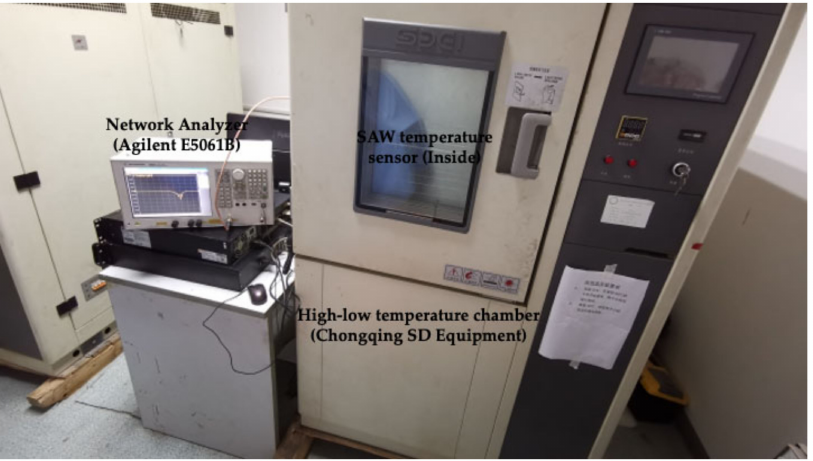
Figure 11. Cryogenic temperature test